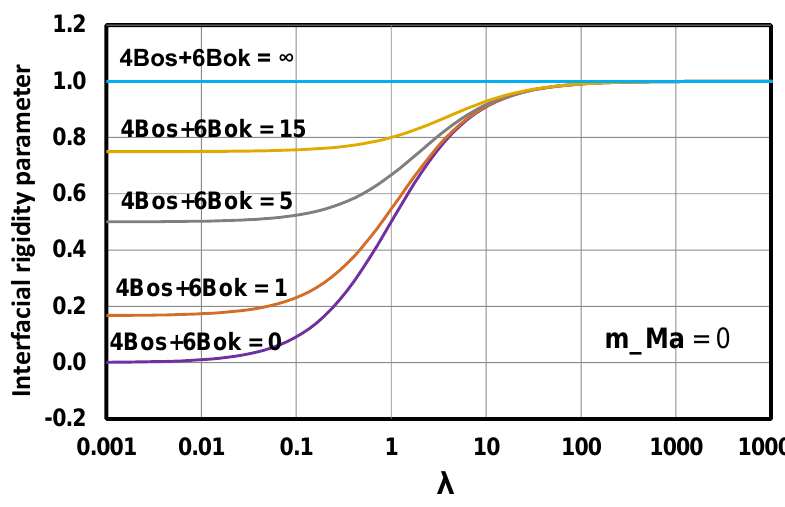
Figure 23. Plots of ε r versus λ for different values of the interfacial viscosity term 4 Bo s + 6 Bo k